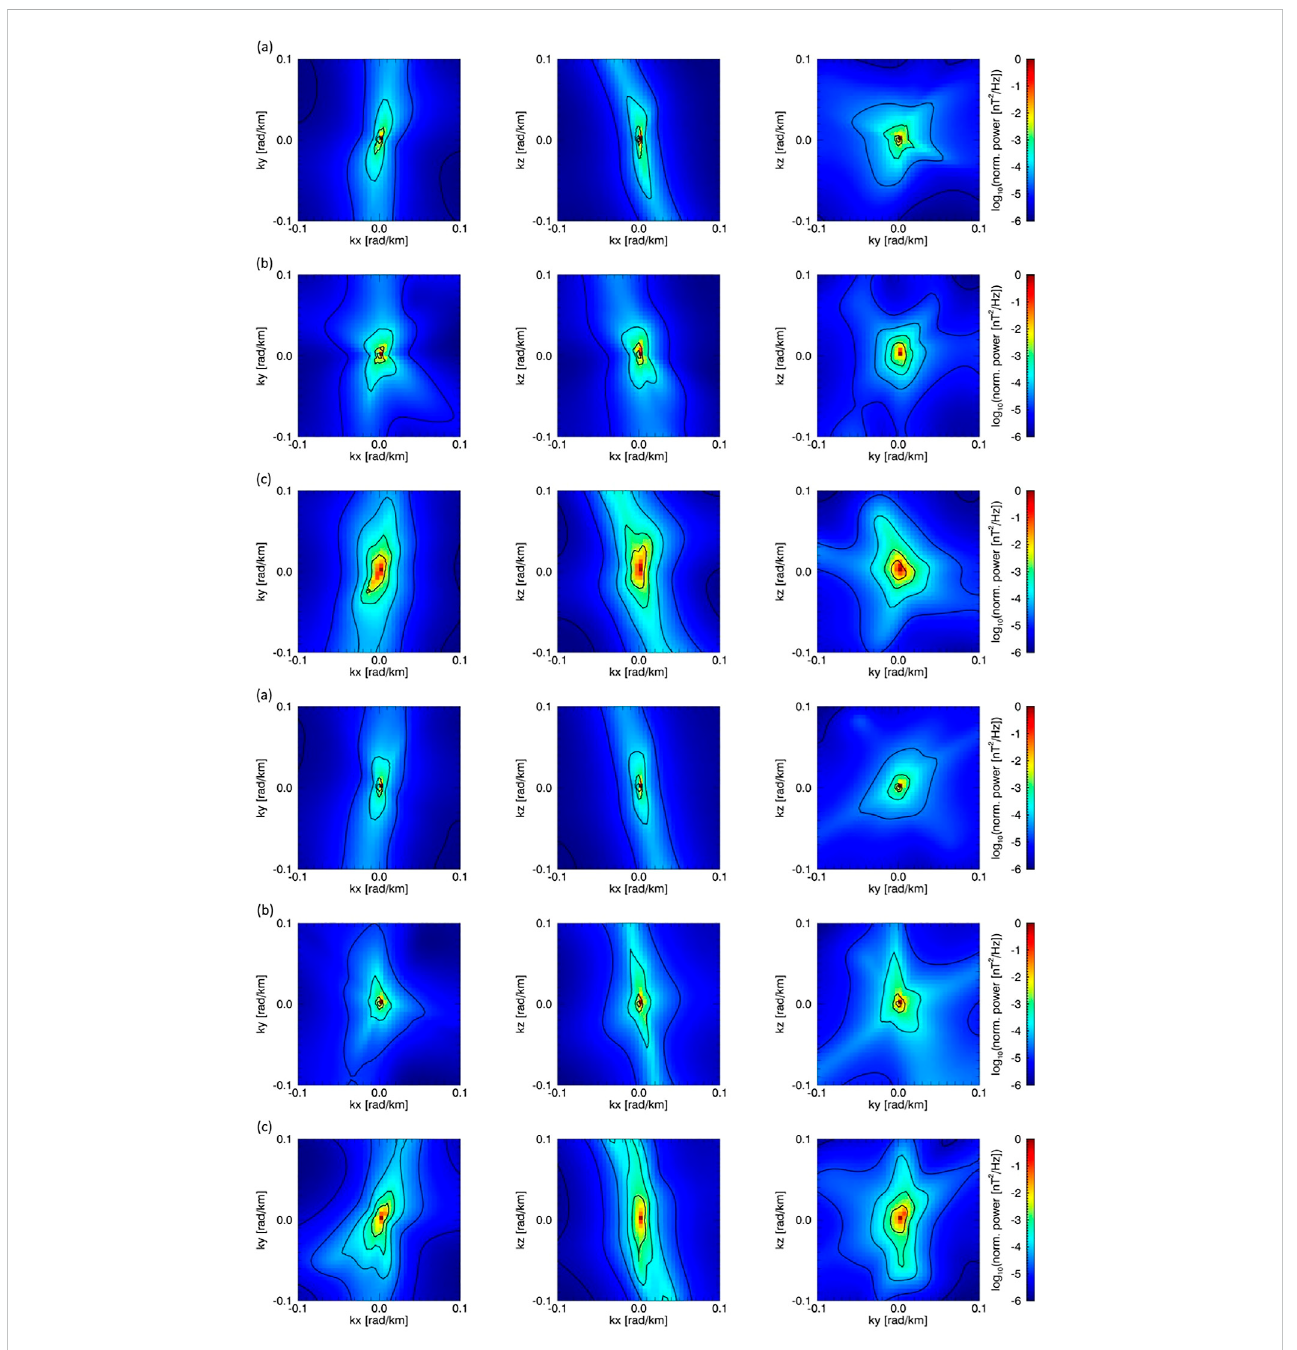
FIGURE 5 (cid:22) → MSR3Dpowerspectraof δ B in kx − ky , kx − kz ,and ky − kz planesforthedominantfrequenciesofthe fi rst fl appingevent[(1),0.02 (A) ,0.05 (B) ,and0.5 (C) Hz from top to bottom] and the second fl apping event [(2), 0.02 (A) , 0.046 (B) , and 0.5 (C) Hz from top to bottom]